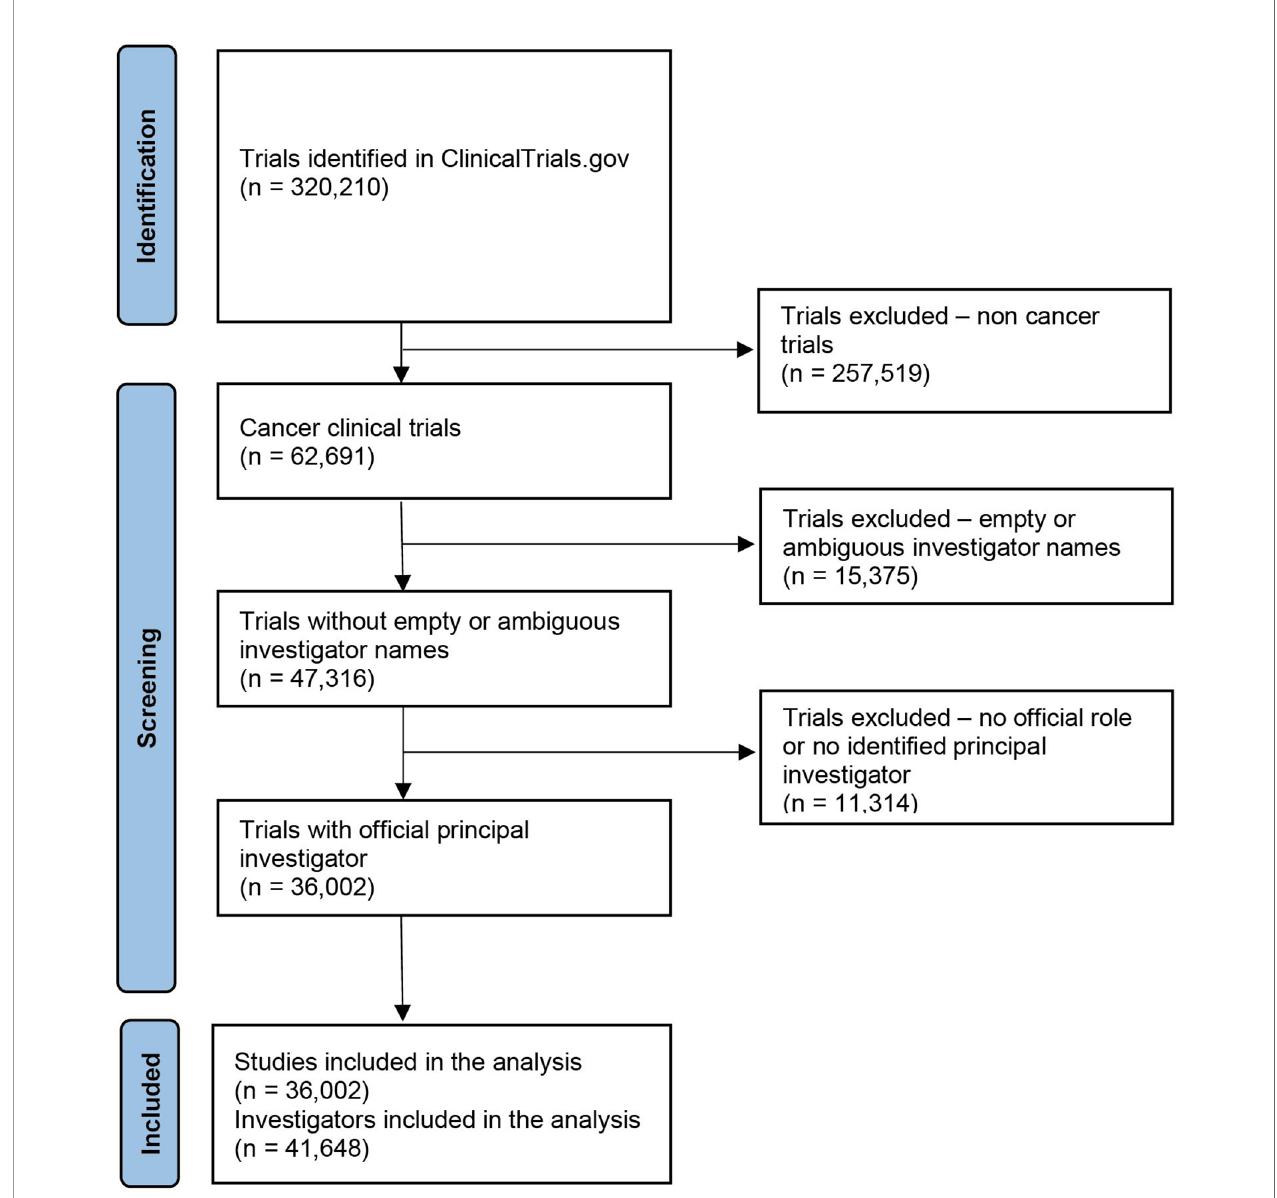
FIGURE 1 | Flow chart of trial screening and